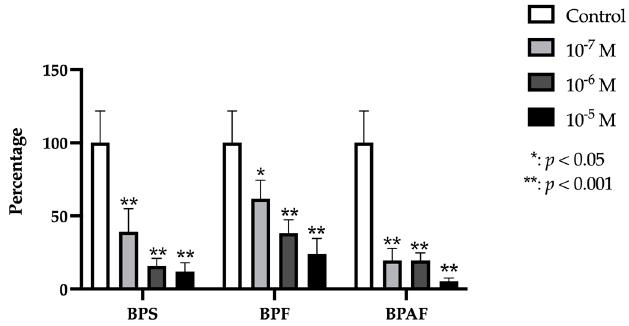
Figure 5. Expression of OSC in primary human osteoblasts treated for 24 h with bisphenol S, F, and AF (10 − 7 , 10 − 6 , or 10 − 5 M). The assay was performed in triplicate with each of the three primary human osteoblast cell lines. Data are expressed as percentage expression with respect to control ± standard deviation. Significant differences * p < 0.05; ** p < 0.001.